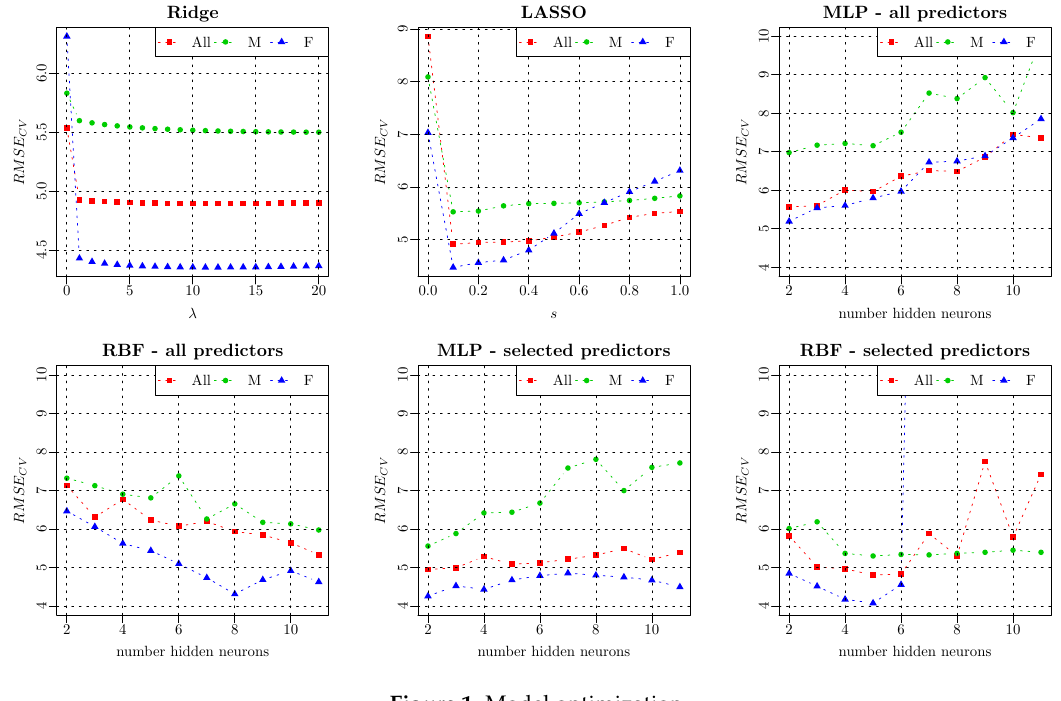
Figure 1. Model optimization. Table 3. Mathematical models for all